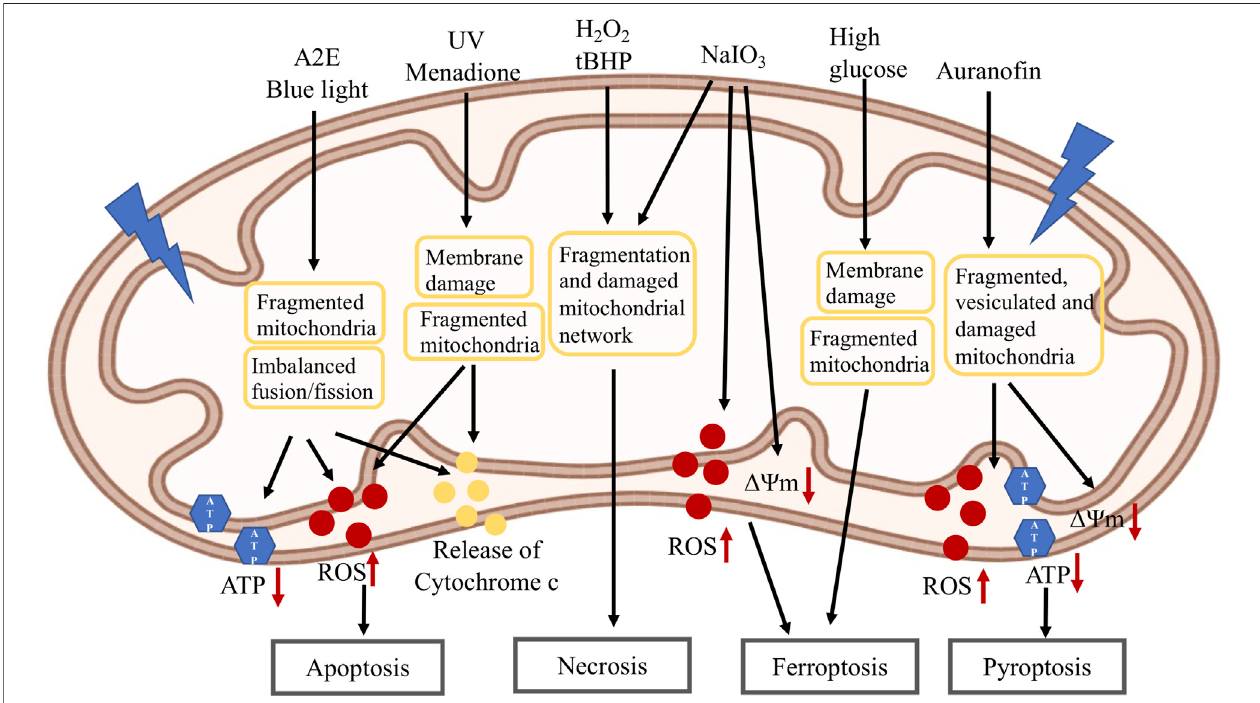
FIGURE4| MitochondriachangesinRPEcelldeathinducedbydifferentstressors: A2Eandbluelightleadtofragmentedmitochondria,imbalancedmitochondrial fusion/ fi ssion,decreasedATPlevel,increasedROSlevelandreleaseofcytochromeCwhichtheninduceapoptosis;UVandmenadionecausemitochondrialmembrane damage, fragmented mitochondria, increased ROS level and release of cytochrome C which then induce apoptosis; H 2 O 2 , tBHP and NaIO 3 cause fragmented mitochondria and damaged mitochondrial network, and lead to necrosis. NaIO 3 also induces decreased mitochondrial membrane potential and increased ROS level, and leads to ferroptosis. High glucose induces mitochondrial membrane damage, fragmented mitochondria and cause ferroptosis; Aurano fi n causes decreased mitochondrial membrane potential, fragmented, vesiculated and damaged mitochondria, increased ROS level and decreased ATP level which lead to pyroptosis. A2E: N-retinylidene-N-retinyl-ethanolamine; UV: ultraviolet; H 2 O 2 : hydrogen peroxide; tBHP: tert-butyl hydroperoxide; NaIO 3 : sodium iodate; ATP: adenosine triphosphate; ROS: reactive oxygen species; ΔΨ m: mitochondrial membrane